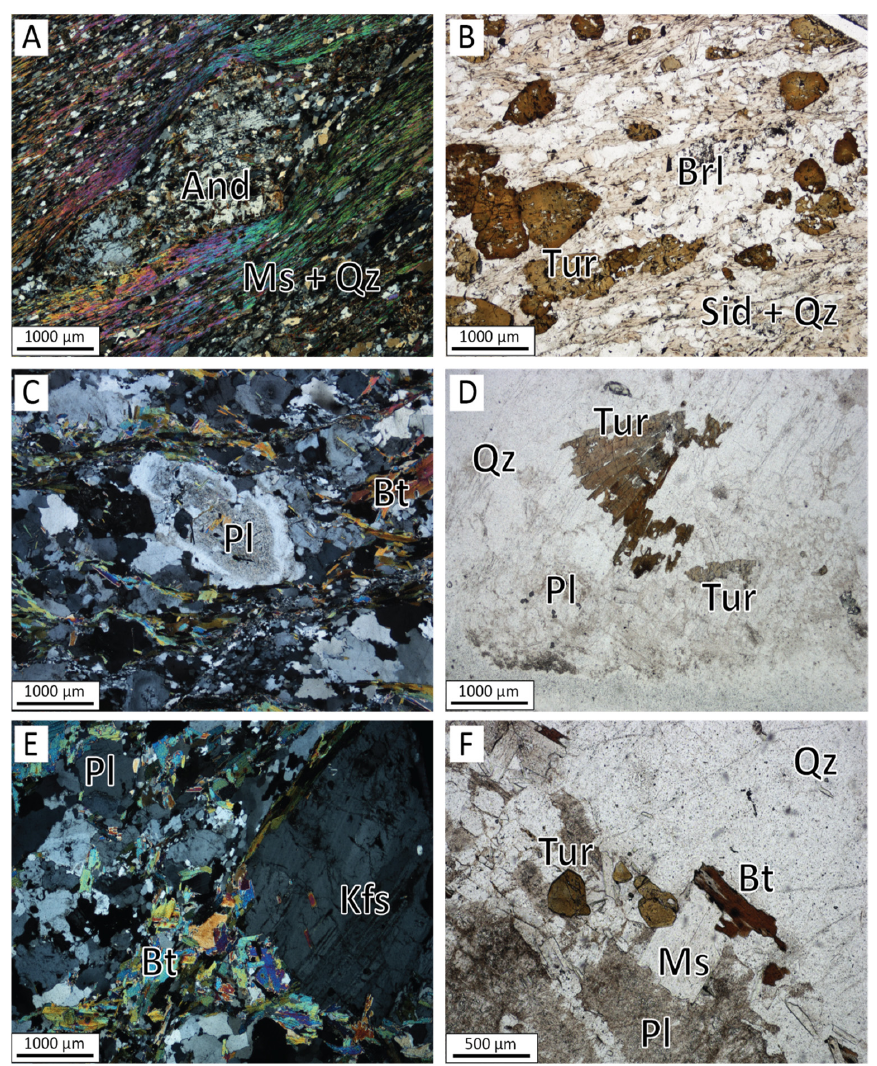
Figure 5. Mineralogy and textures in wall rocks. Mineral abbreviations: And = andalusite, Brl = beryl, Bt = biotite, Kfs = K-feldspar, Ms = muscovite, Pl = plagioclase, Qz = quartz, Sid = siderophyllite, Tur = tourmaline; samples from drill holes in parentheses. ( A ) Inclusion-rich andalusite porphyroblasts enveloped by aligned muscovite in mica schist (ACL 13-02). ( B ) Medium- grained light brown tourmaline crystals with dark brown rims within light pink siderophyllite, beryl and quartz in spodumene pegmatite exocontact in mica schist (ACL 13-02), 2 cm away from the contact with spodumene pegmatite. ( C ) Zoned plagioclase megacryst with inclusion-rich core and clear rim with irregular borders, within aligned biotite and muscovite crystals in foliated granodiorite (ACL 13-04). ( D ) Radiating tourmaline “poikiloblast” adjacent to quartz and zoned plagioclase in footwall granodiorite exocontact to spodumene pegmatite (ACL 13-04), 2.5 cm away from the contact with spodumene pegmatite. ( E ) Microcline megacryst in porphyritic granodiorite (MOY 13-03). ( F ) Tourmaline crystals in spodumene pegmatite exocontact in porphyritic granodiorite (MOY 13-03), 3 cm away from the contact with spodumene pegmatite.